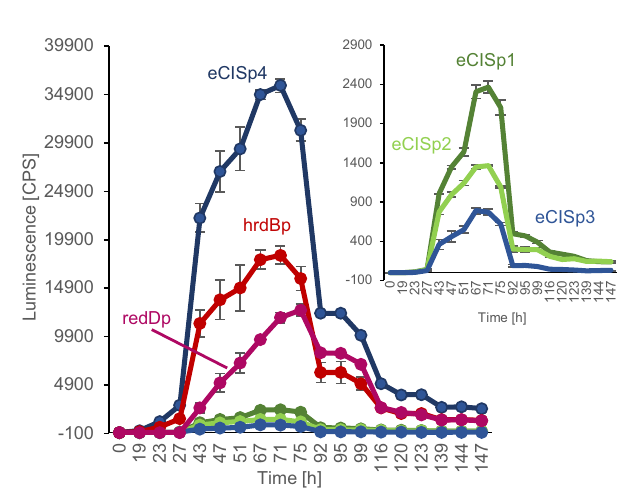
Fig. 5 | The eCIS cluster of S. coelicolor is expressed during vegetative growth rightbeforethedevelopmentalswitch. AfusionconstructofeacheCISpromoter (eCISp1-p4,correspondingtopromotersP1-P4showninFig.1b)with luxCDABE was conjugated with Sco and grown on 96-well MS agar plates for 7 days. hrdBp and redDp reporter strains were used as controls. Luminescence was measured three times aday. Activity ofthe weakerpromoters: eCISp1,eCISp2 and eCISp3 isshown in enlarged view in the top right insert. Three biological replicates were tested for each assay ( n =3). The mean normalized to empty vector is shown with error bars representing standard deviation of the mean. Source data are provided in the Source Data fi